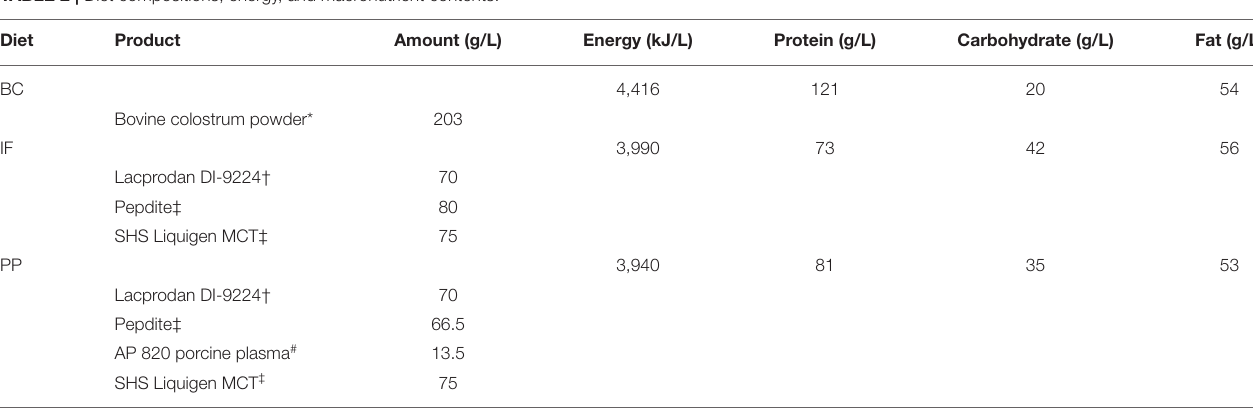
TABLE 2 | Diet compositions, energy, and macronutrient